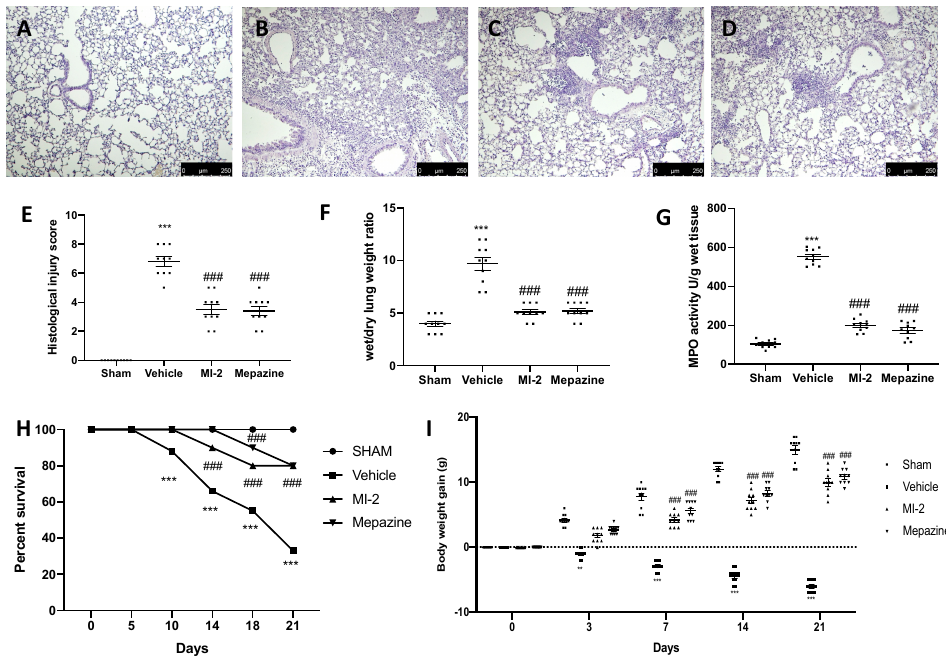
Figure 1. Effect of MI-2 on histological changes, lung edema, MPO activity, survival rate and body weight: hematoxylin and eosin staining of sham ( A ), vehicle ( B ), MI-2 ( C ), Mepazine ( D ), histological injury score ( E ), wet/dry lung weight ratio ( F ), MPO activity ( G ), survival rate ( H ), body weight gain ( I ). For each analysis, n = 10 animals from each group were employed.